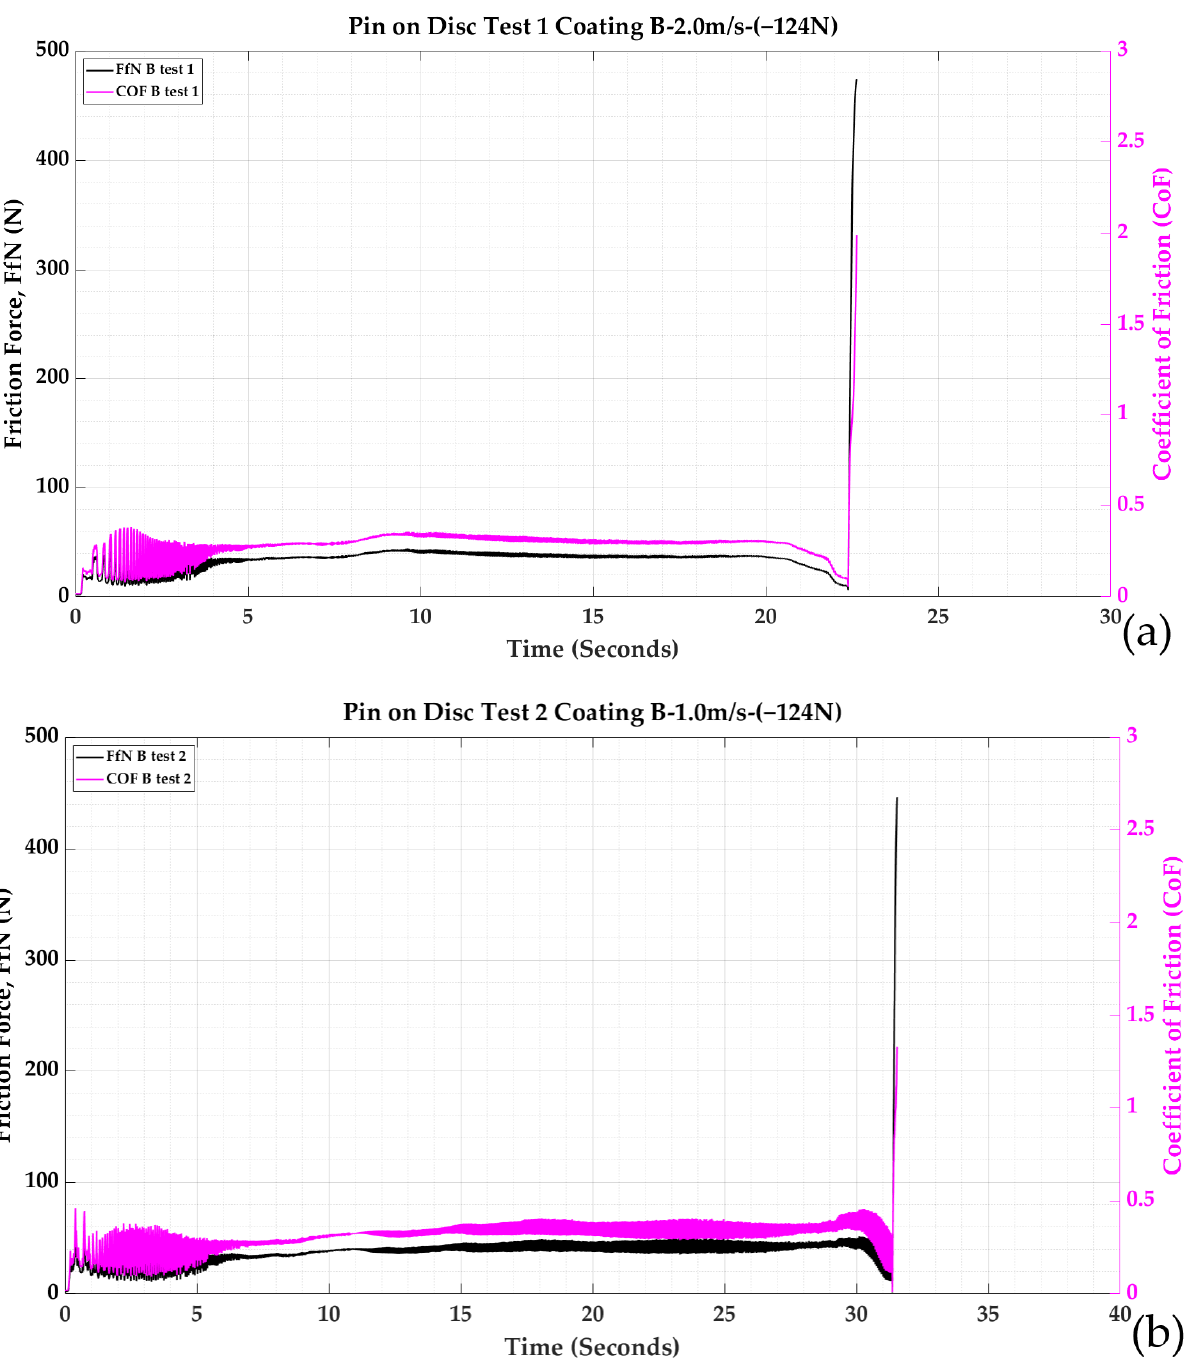
Figure 4. Friction coefficient plot vs. time (seconds) vs. friction force (N): ( a ) Test 1b and ( b ) Test 2b for Coating B.